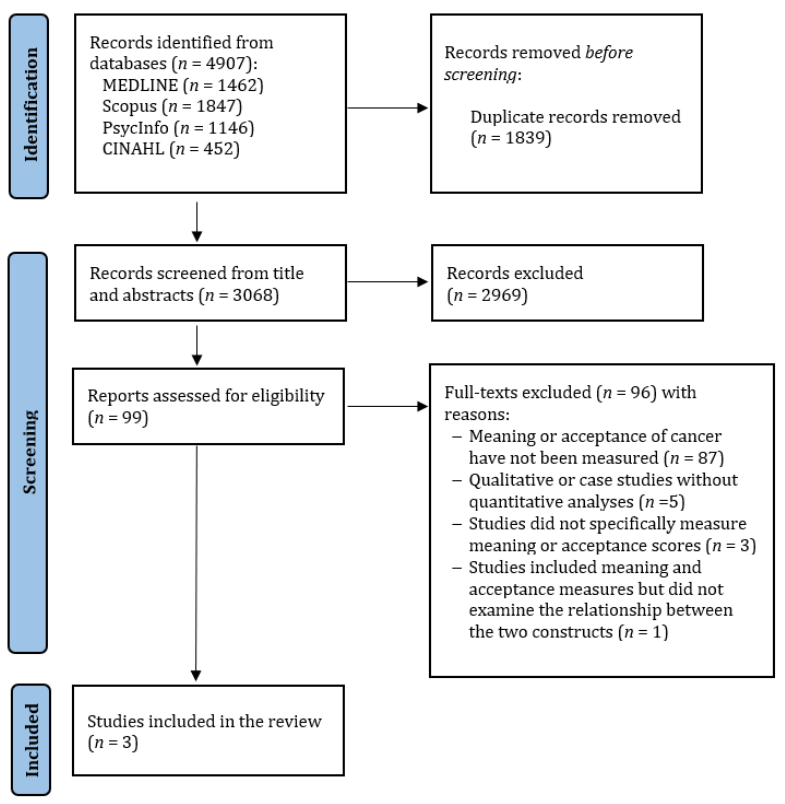
Figure 1. PRISMA flow diagram showing the selection of primary studies.